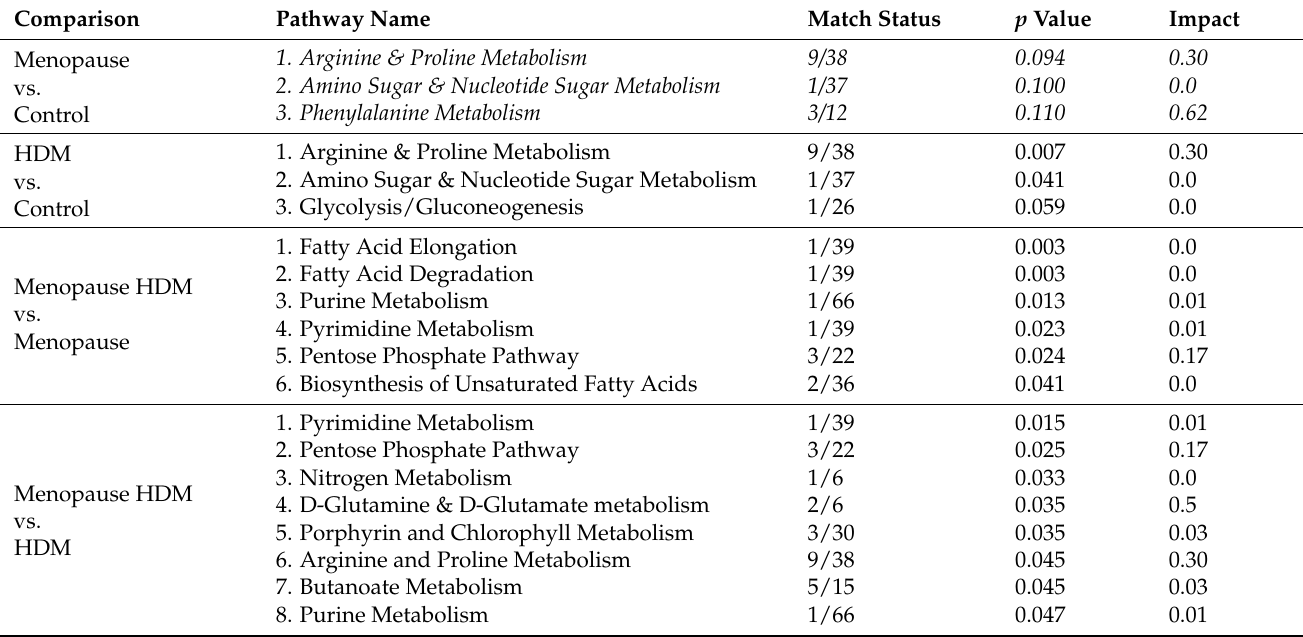
Table 3. Significantly impacted metabolic pathways in the BALF.